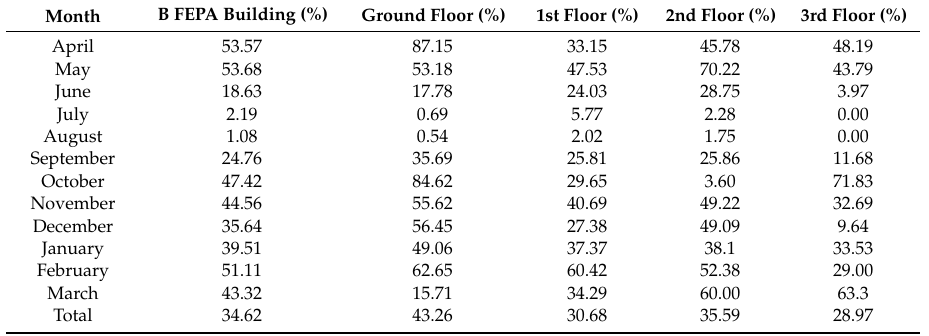
Table 3. Percentages of measured indoor temperature values within the recommended limit